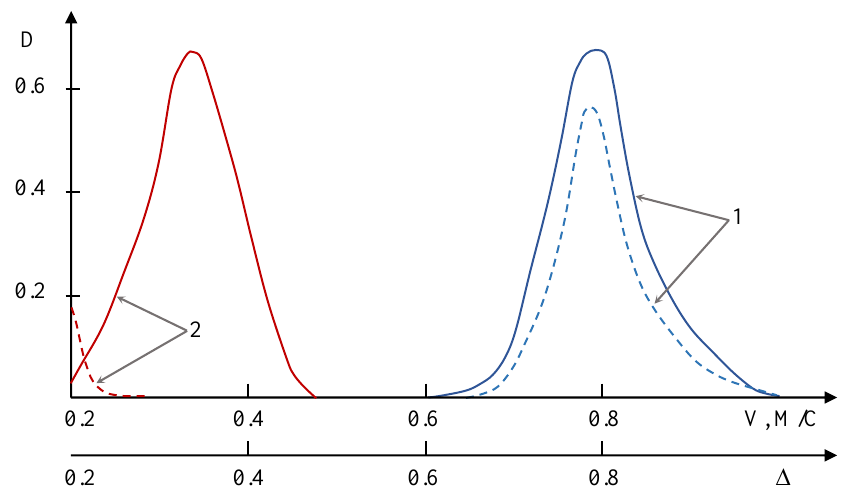
Figure 6. Sensitivity of the generalized criterion to the variation in factors: 1— D ( ν ) , 2— D ( ∆ ) (Solid lines—in the vicinity of the optimum; dashed—in the vicinity of the center of the experiment